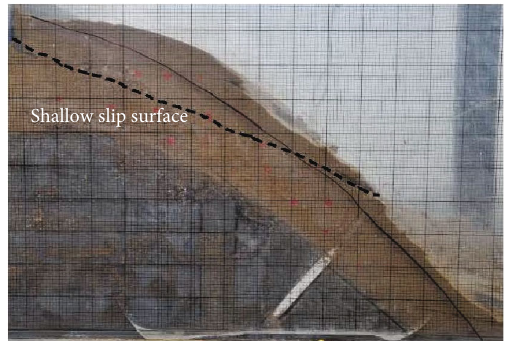
Figure 11: Shallow slip surface of the landslide.